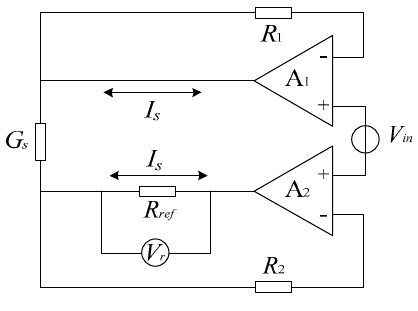
Figure 2. Equivalent circuit of conductivity measurement.